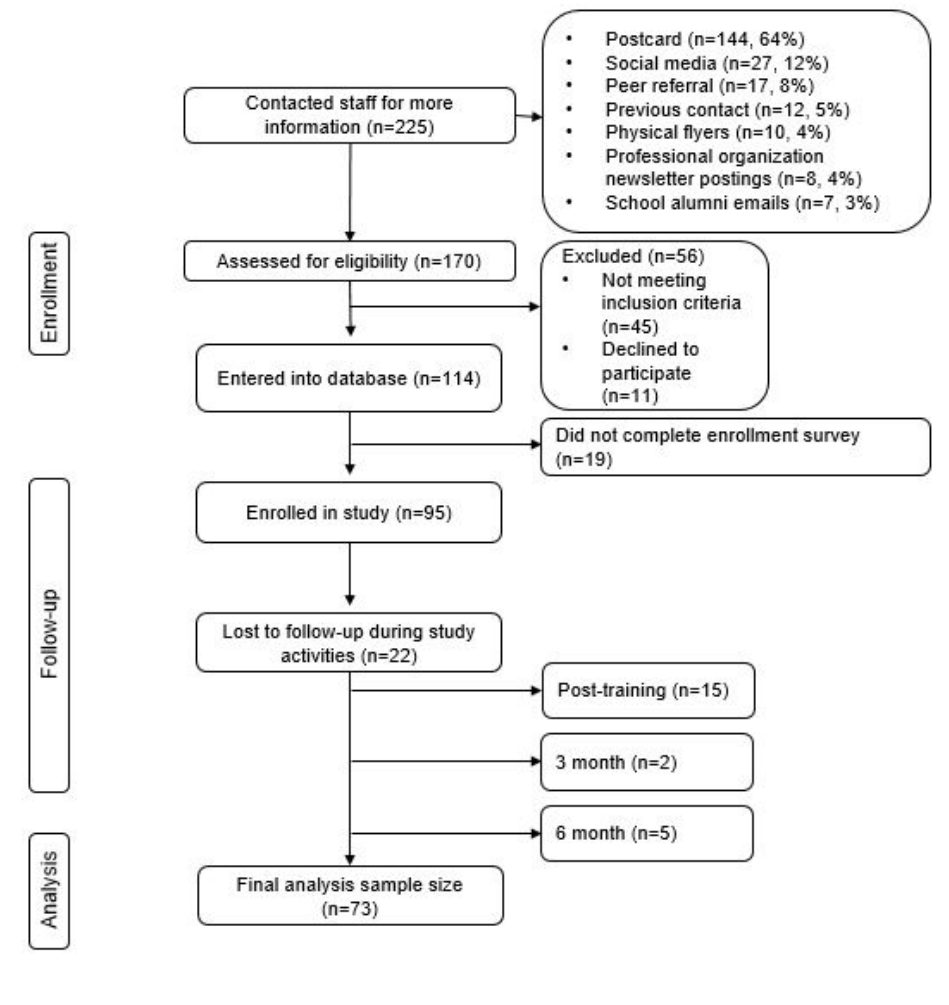
Figure 1. CONSORT (Consolidated Standards of Reporting Trials) flow